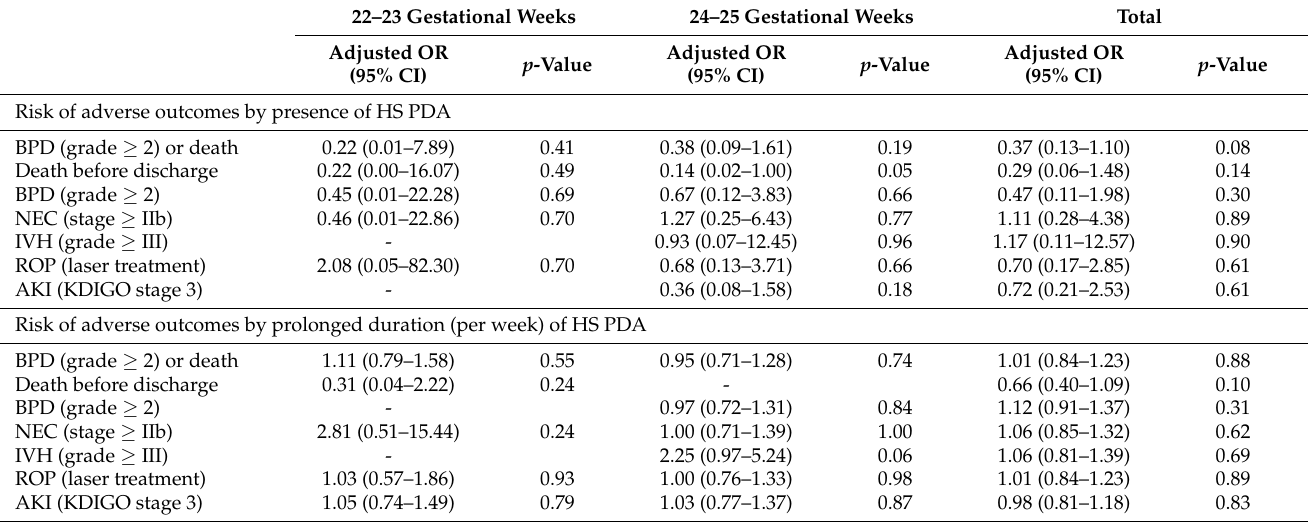
Table 5. Adjusted odds ratios for the risk of adverse outcomes by presence or duration of HS